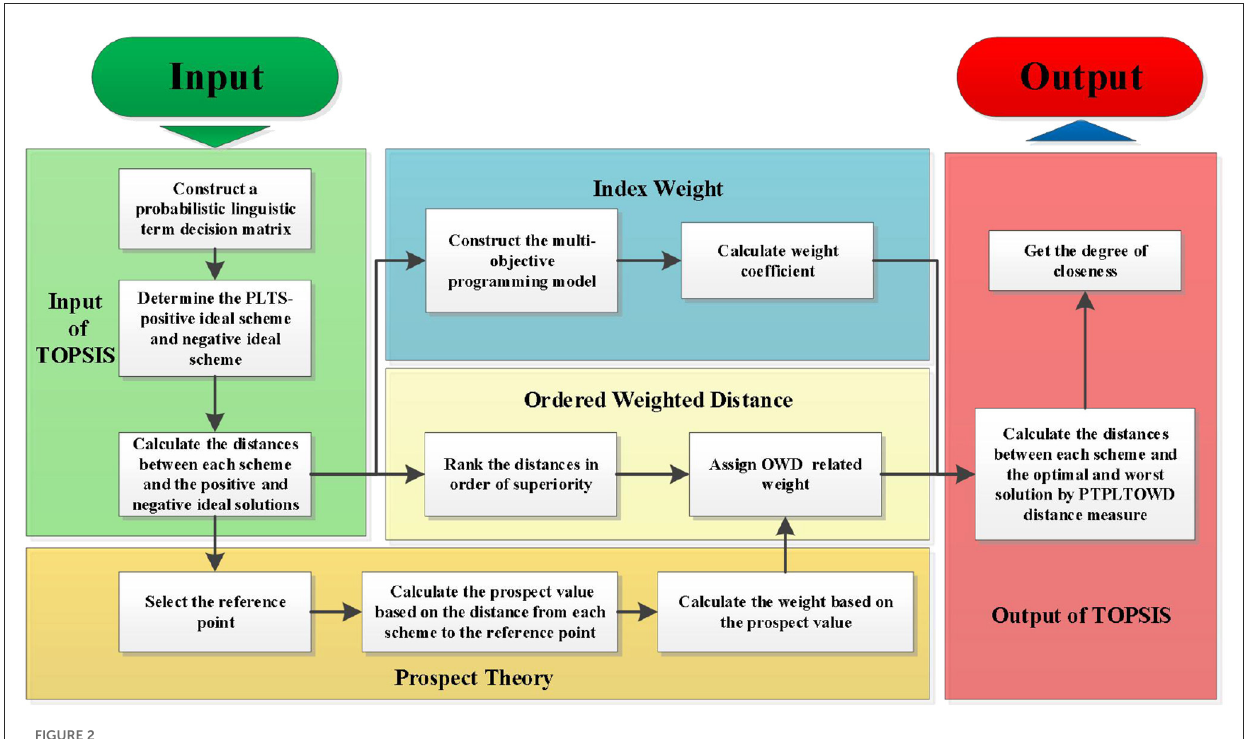
FIGURE2 Flowchart of the PTPLTOWD-TOPSIS